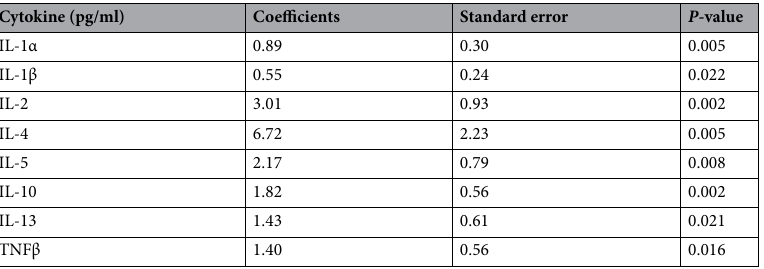
Table 3. Association of inflammatory cytokines with choroidal vessel diameter in pachychoroid neovasculopathy (PNV). PNV, pachychoroid neovasculopathy. Multivariate linear regression analyses of subfoveal choroidal thickness after age, sex, and number of polypoidal lesions adjustment in PNV. PNV, n = 75.